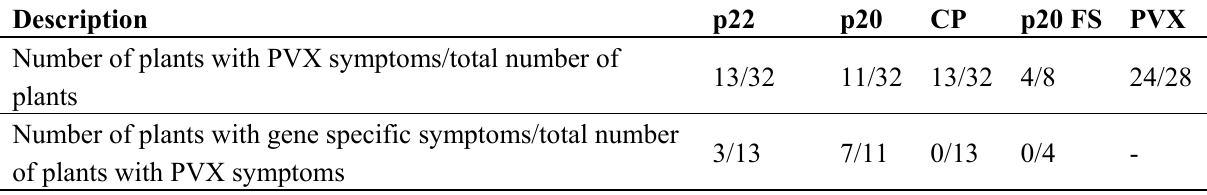
Table 4. Plants displaying specific unique symptoms after infection with PVX containing selected PMWaV-2 ORFs. Results are means of three experiments (p20, p22, and CP), except for p20FS, which represents a single experiment. All plants that displayed PVX or gene-specific symptoms were also PCR positive for both the PVX and selected ORF